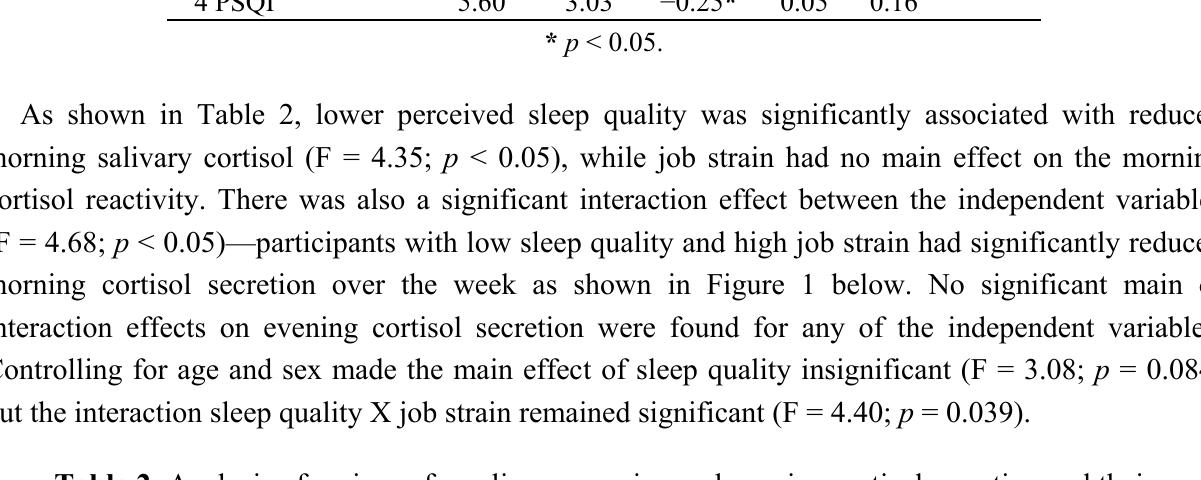
Table 2. Analysis of variance for salivary morning and evening cortisol secretion and their difference (nmol/L—for Low/High Job Strain, and Low/High Sleep Quality, N = 76). Values enclosed in parentheses represent mean square